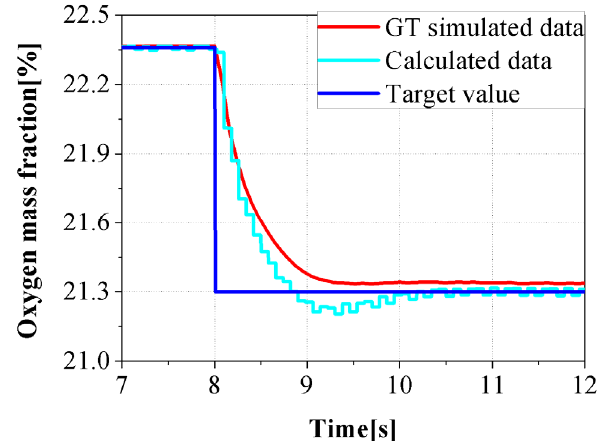
Figure 9. Step response of the control